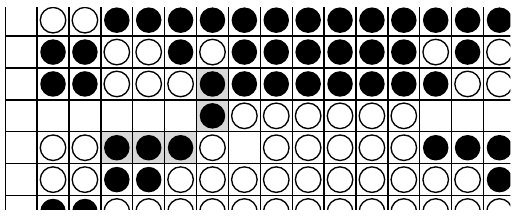
Figure 92. WHITE wins.